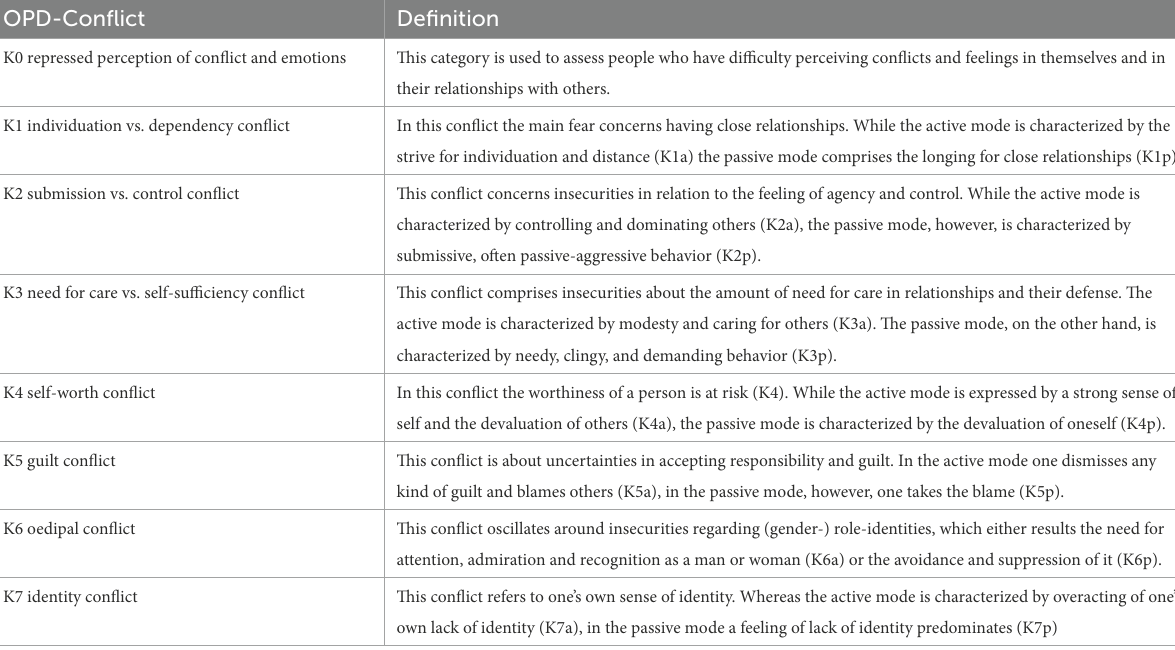
TABLE 2 Definition of the OPD category repressed perception of conflict and emotions and the conflict modes.